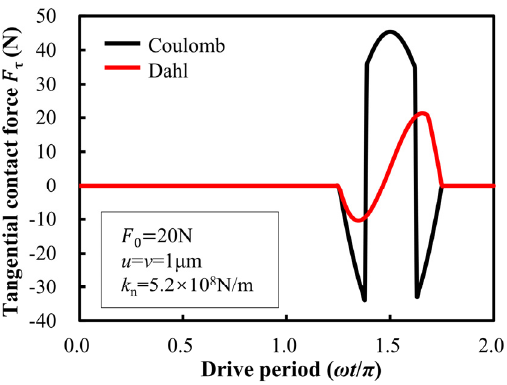
Figure 10. Periodic comparison of tangential contact forces for Dahl model and Coulomb model.